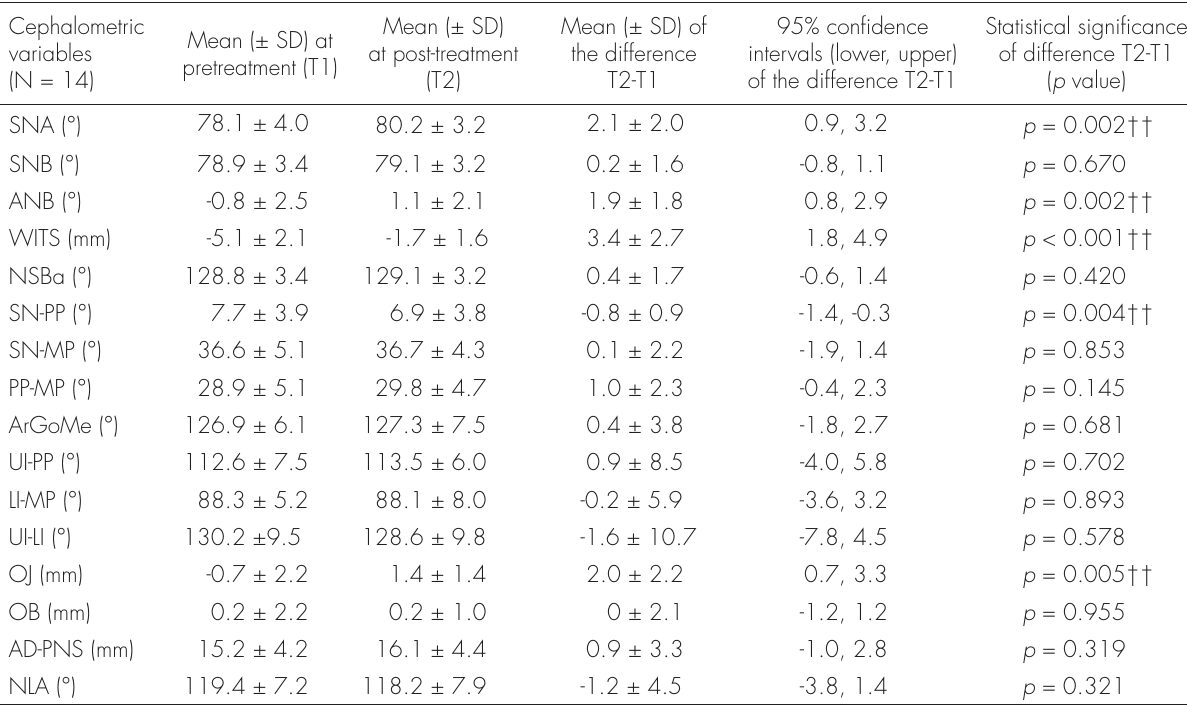
Key: †† Statistically significant at p <